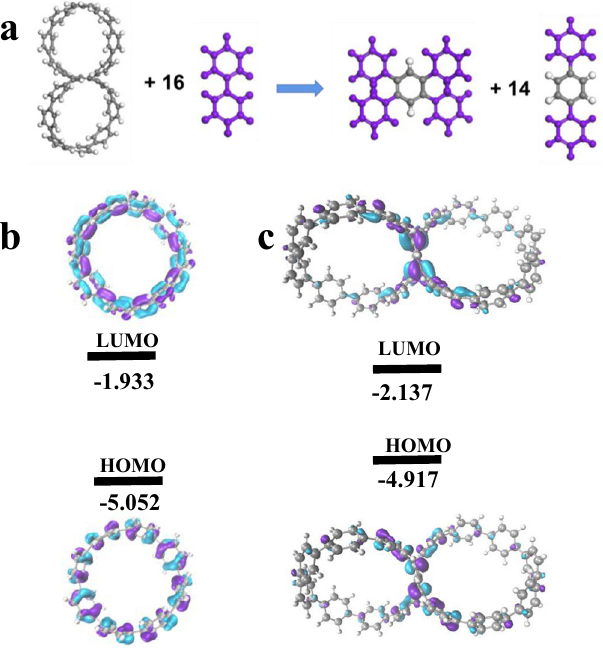
Fig. 3 Theoretical calculations. a Homodesmotic equation for the calculation of strain energy for SCPP[8] . b LUMO and HOMO of [8]CPP. c LUMO and HOMO of SCPP[8]